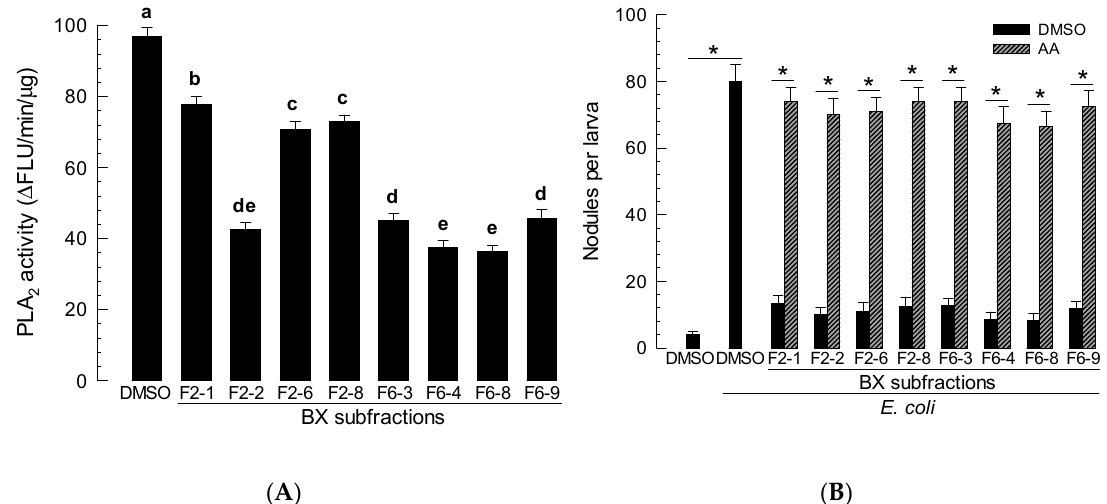
Figure 3. Screening eight butanol subfractions of X. hominickii culture broth. ( A ) Inhibitory activities of the subfractions against hemocyte PLA 2 of S. exigua . ( B ) Inhibitory activities of the subfractions against hemocyte nodule formation. Each bacterial extract (1 µL/larva) were injected into L5 larvae along with E. coli (3 × 10 4 cells/larva). Arachidonic acid (AA, 10 µg/larva) was injected along with the extract and E. coli . Dimethyl sulfoxide (DMSO) was used for solvent control. Each measurement was replicated three times with independent samplings. Different letters or asterisks above standard deviation bars indicate significant differences among means at Type I error = 0.05 (LSD test).